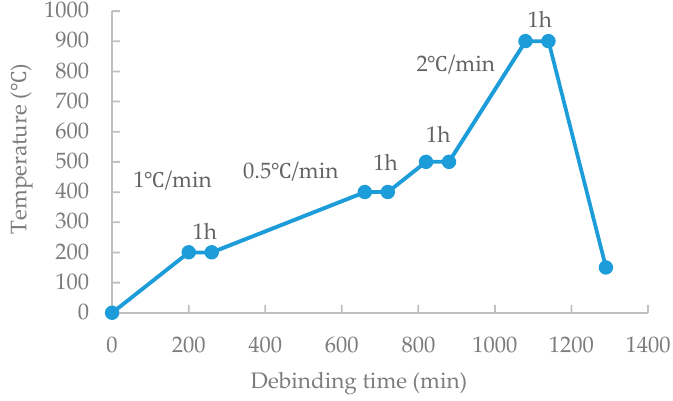
Figure 11. An optimized thermal debinding profile with pre-sintering process.